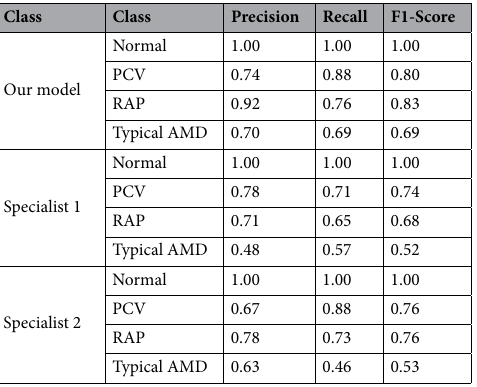
Table 3. Classification results of comparative performance of Our model and 2 retina specialist. OCT optical coherence tomography, neovascular AMD neovascular age-related macular degeneration, RAP retinal angiomatous proliferation, PCV polypoidal choroidal